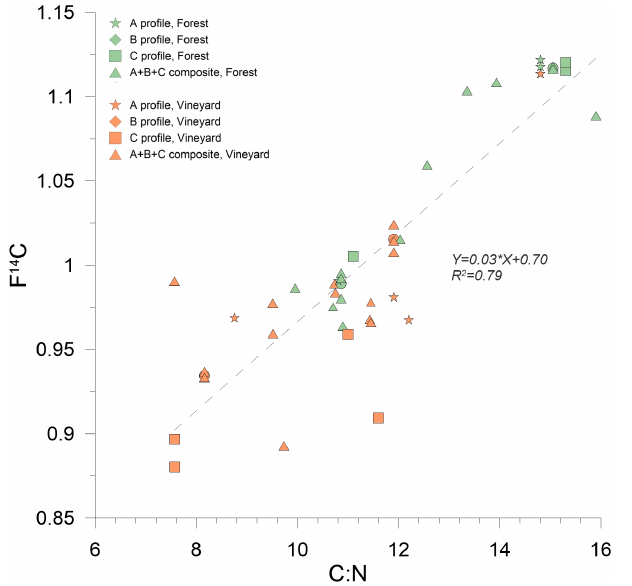
Figure 6. Correlation between the F 14 C and C : N ratio. The corre- lation was calculated on composite samples (F 14 C) and the average for the three profiles A, B, and C (C : N), as well as on samples of profiles A, B, and C only, from the forest (green) and vineyard